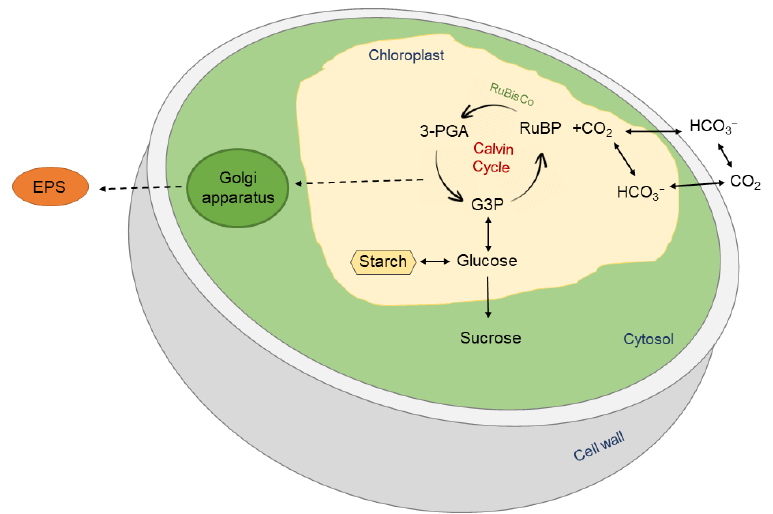
Figure 1. Illustrative representation of carbohydrate synthesis in the microalgal cell (CO 2 : carbon dioxide, EPS: exopolysaccharide, G3P: glyceraldehyde-3-phosphate, HCO 3 − : bicarbonate, RuBP: Ribulose-1,5-bisphosphate, 3-PGA: phosphoglycerate).